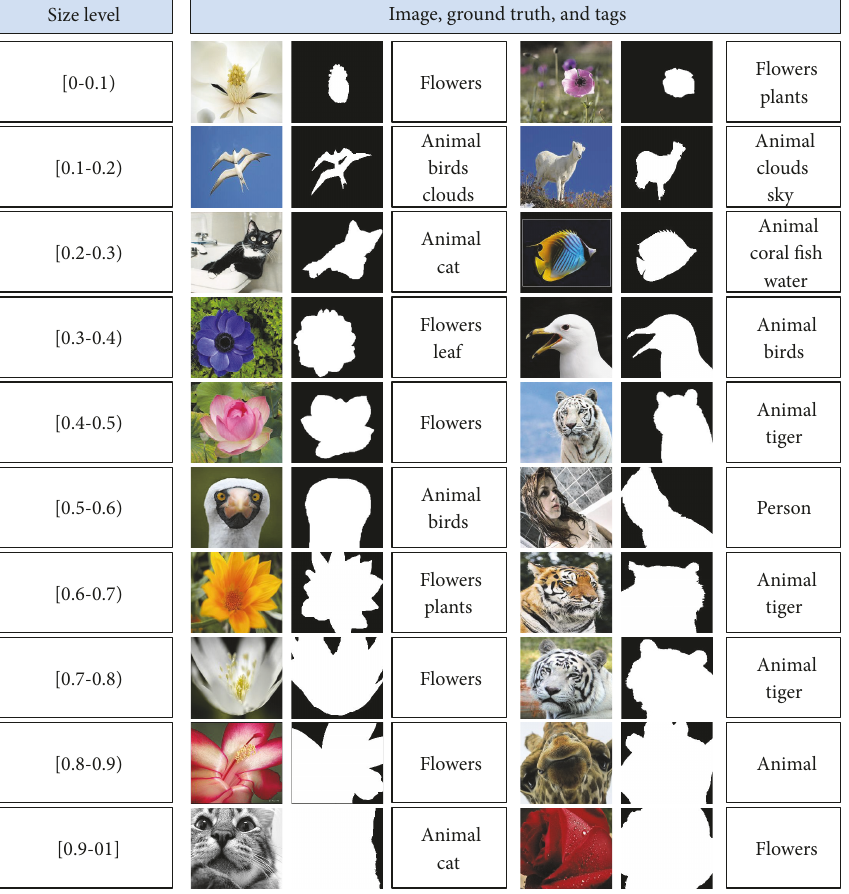
Figure 10: Images in various size